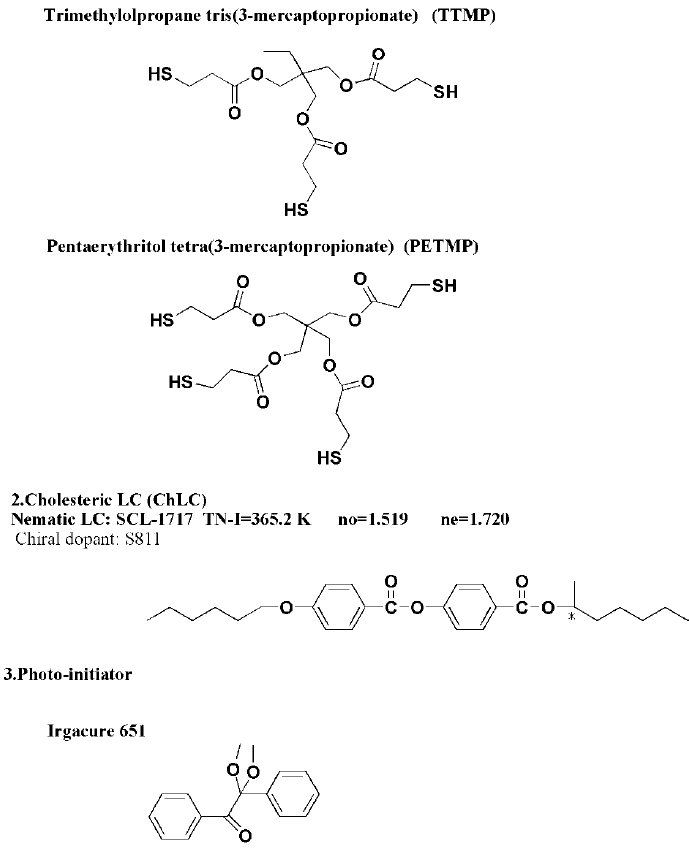
Figure 10. The chemical structures of the materials used. TMHA: 3,5,5-Trimethylhexylacrylate; BDDA: 1,4-butanedioldiacrylate; LC: liquid crystal; SCL-1717: nematic liquid crystal; no: ordinary refraction index; ne: extraordinary refraction index.